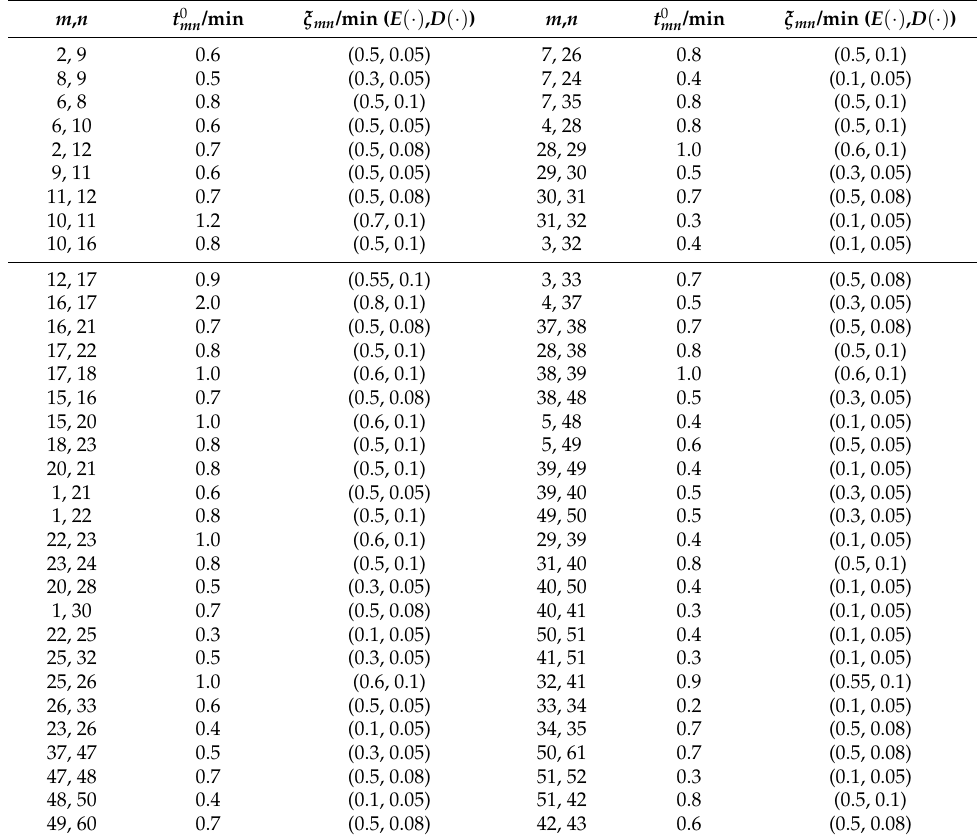
Table 6. The travel time of links.